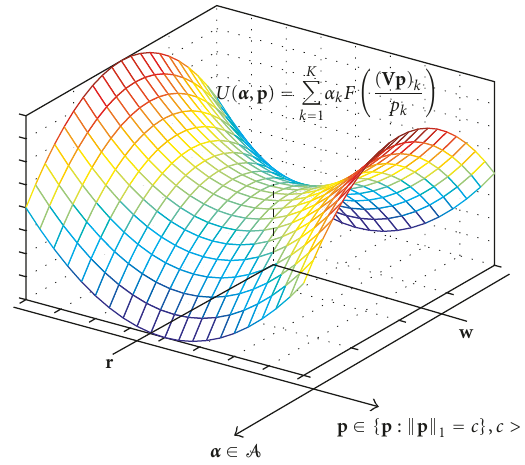
Figure 1: Figurative visualization of the saddle point property of the min-max fair and utility-optimal power and weight allocation. The two scalar dimensions represent the spaces of power allocations and weight allocations, respectively. The visualized saddle point is unique, as would be the case for entirely interference-coupled net-